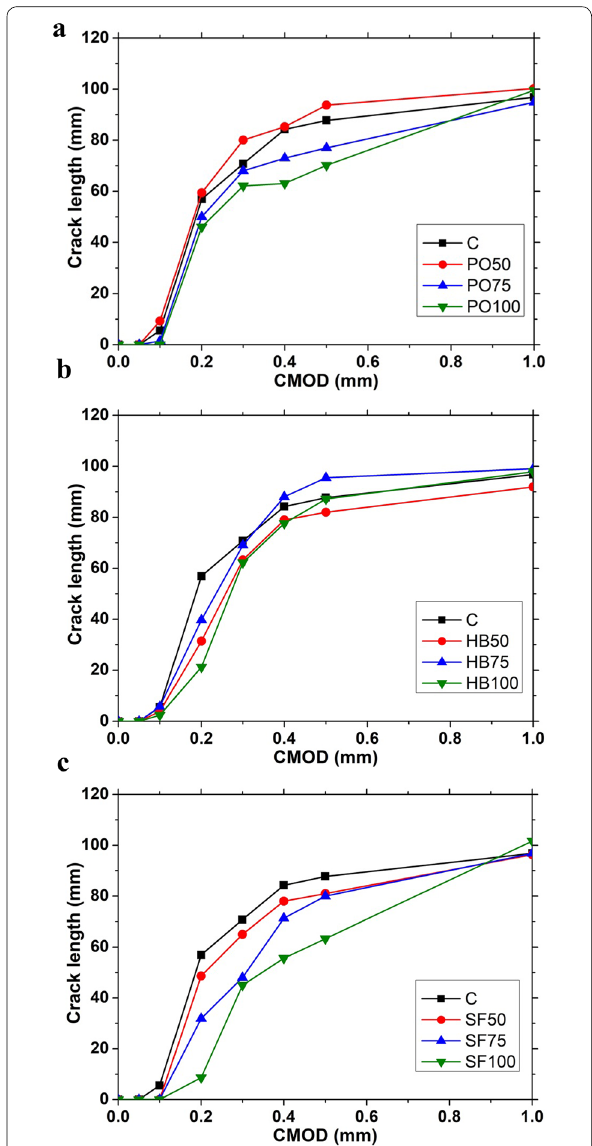
Fig. 15 Effect of fibre dosage and fibre types on crack length Vs. CMOD behaviour: a PO; b HB; c